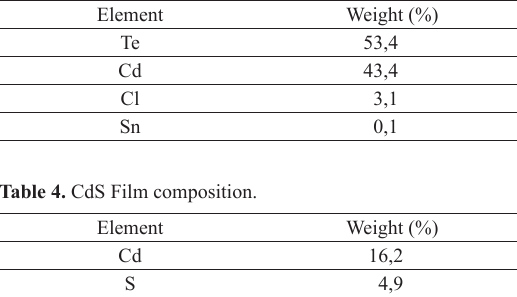
Table 3. CdTe Film